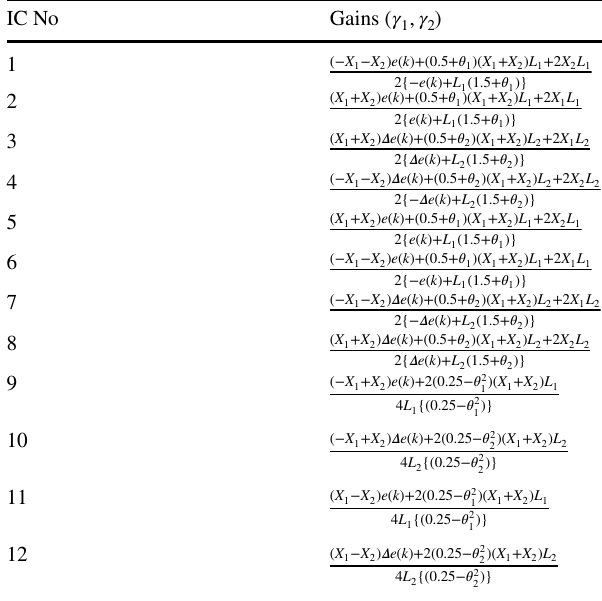
X b X b 1 = 1 and 2 = 2 for 𝛾 2 )